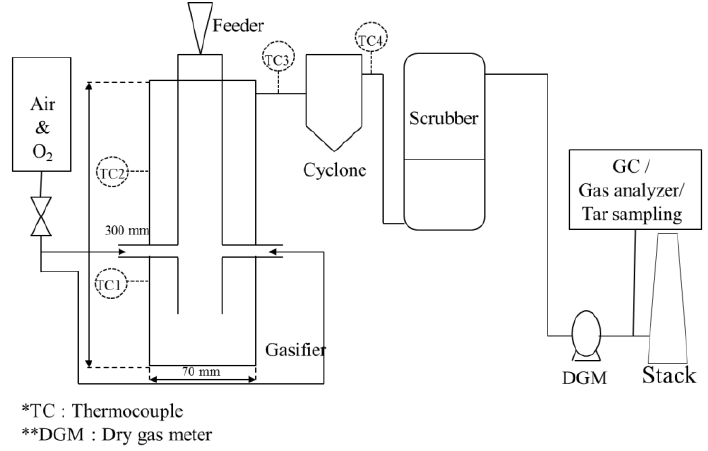
Figure 2. Schematic diagram of the lab-scale gasification process.